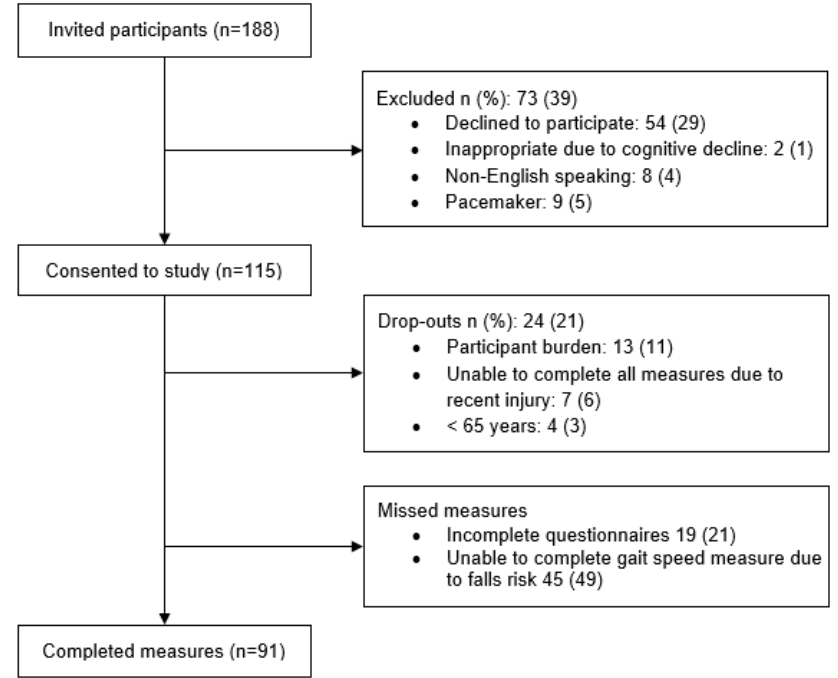
Figure 1. Participant recruitment flow chart.